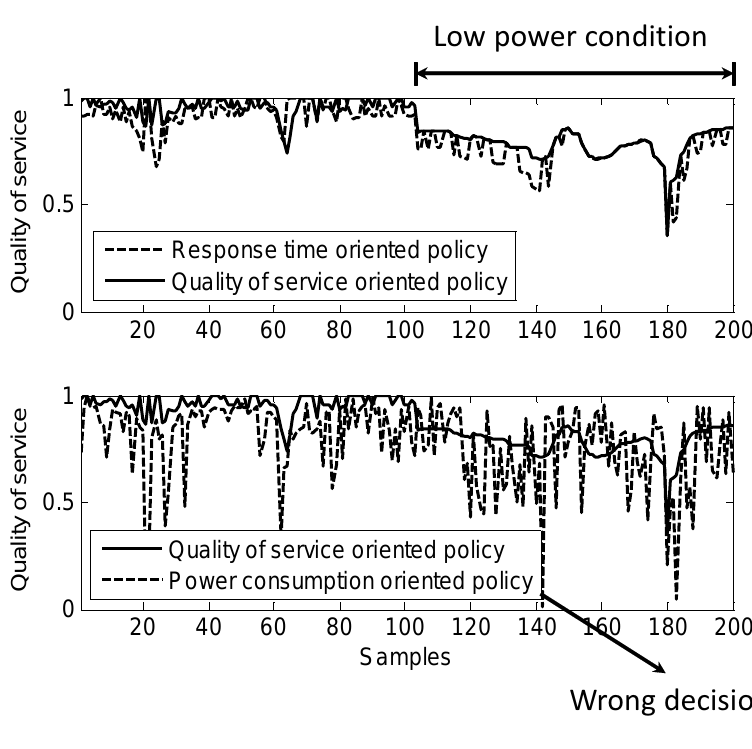
Figure 17. Comparison of the quality of service (QoS).